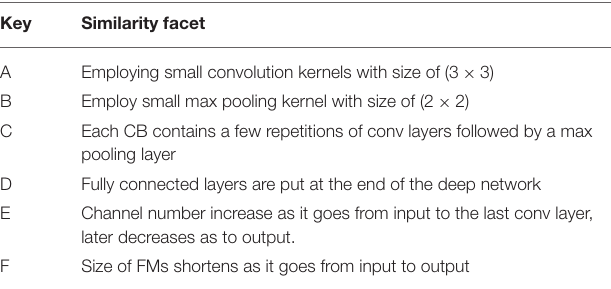
TABLE 4 | Similarity facets between proposed VIN and VGG-16.